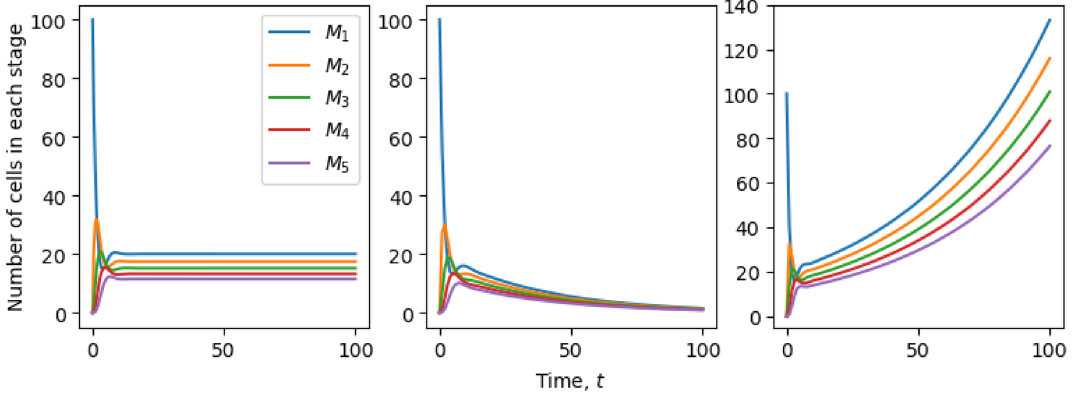
10 2 . Birth = 5 , (cid:31) 0.6 , µ 1 ) (cid:31) . ( 2 1 / N = = = − 5 , = 5 , =